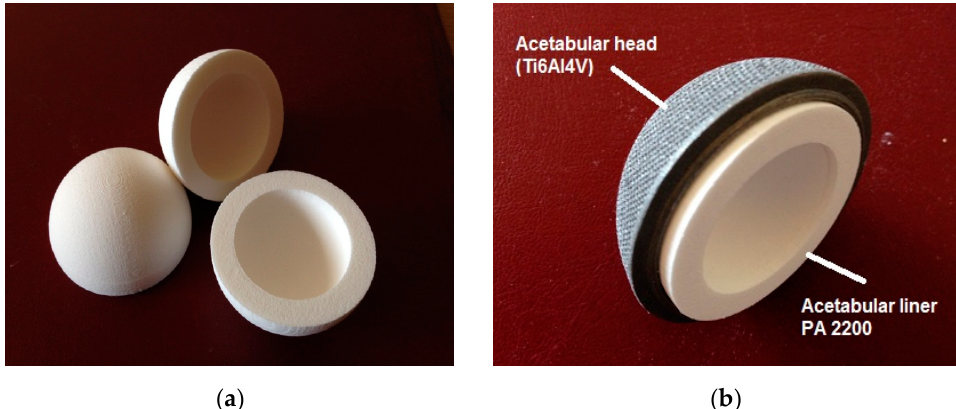
Figure 8. ( a ) Customized medical implant made of PA 2200 by the SLS technology; ( b ) acetabular liner made by the SLS technology and acetabular head made of TiAl6V4 material by SLM 250 HL from SLM Solutions.